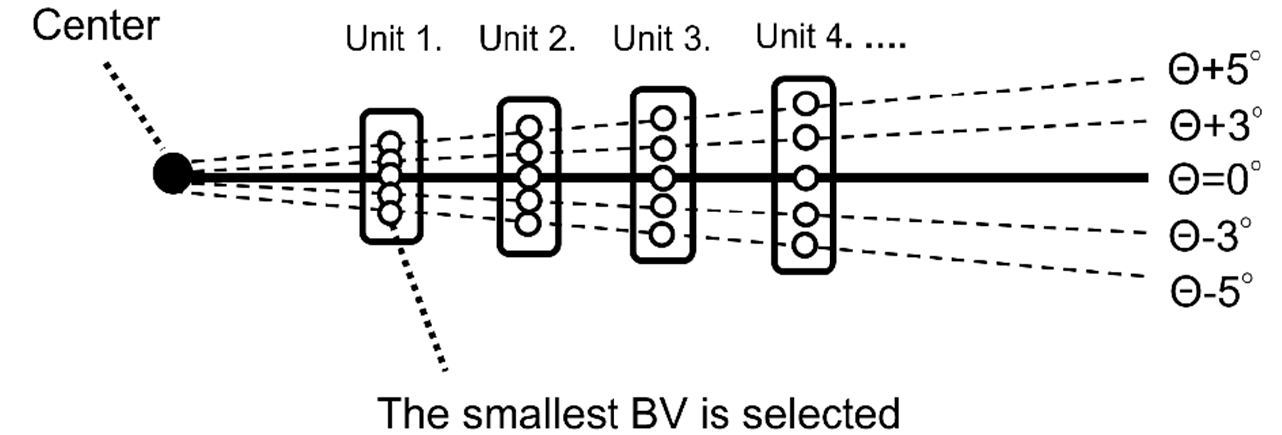
Figure 2. Diagram illustrating the second step used for determining the BV and DV via VK. Briefly, after completing the calculation of the BV for the peak along each meridian within every 10 ◦ unit, the smallest BV within the unit was designated as the representative BV for each unit, and the BV of the whole corneal region was then analyzed. For simplification, note that only units 1~4 are shown and that the meridians for Θ + 1, Θ + 2, Θ + 4, Θ − 1, Θ − 2, and Θ − 4 are omitted, with the associated plot within each 1–4 unit representing the calculated BV. It is also important to note that due to the influence of the upper eyelid and eye lashes on the images, an area from 30 ◦ to 150 ◦ external to the 5th ring (white area (*) in Figure 1) was excluded from the analysis. The DV (arbitrary units) was then determined as the sum of the BVs outside the excluded region.